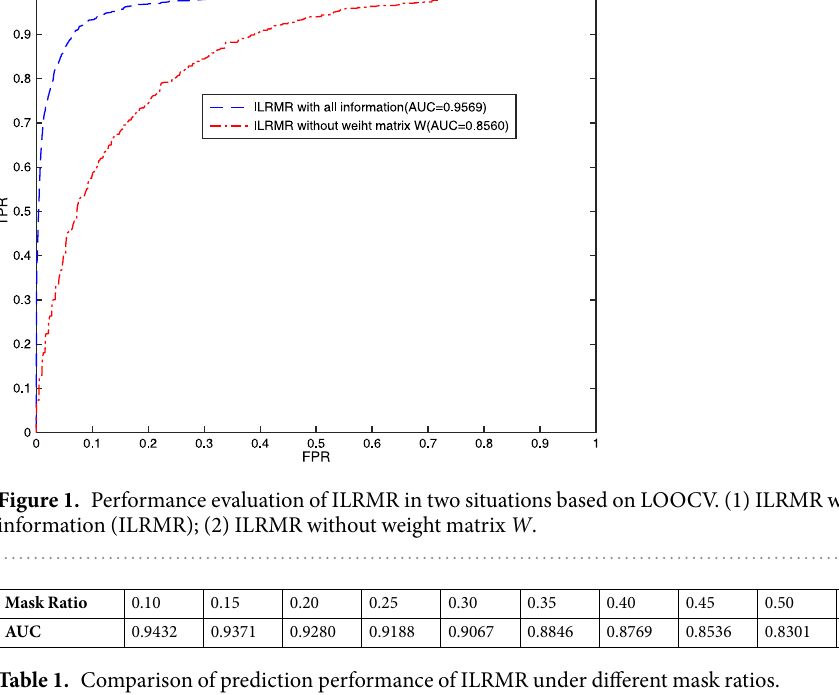
Table 1. Comparison of prediction performance of ILRMR under different mask